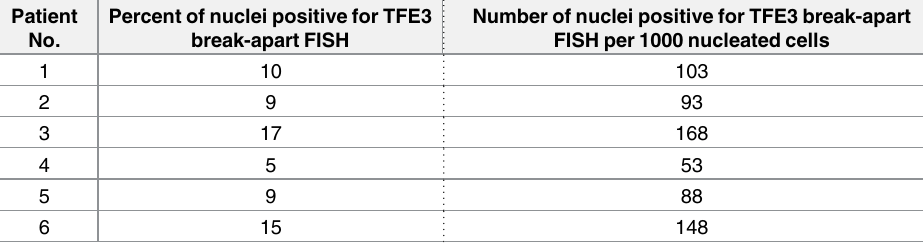
Enumeration of cells with TFE3 break-apart FISH pattern in six patients with metastatic